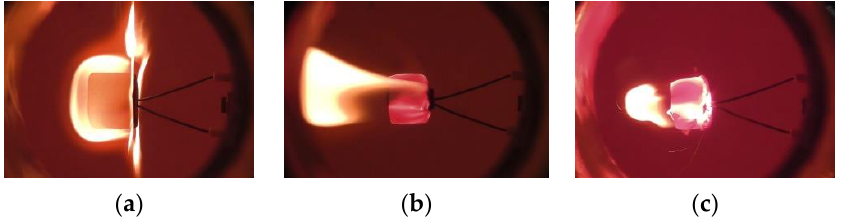
Figure 4. Stages of particle combustion at a furnace temperature of 800 °C and air flow velocity of 20 m s −1 , type A holder. Temperatures indicated under the figures are readings of the thermocouple in the center of a particle. ( a ) 138 °C, ( b ) 340 °C, ( c ) 820 °C. Volatiles are released and burned at the first stage. A flame envelope is torn off from the particle surface when the temperature in its center is as high as 330–350 °C (Figure 4b). The flame base is located at the back face of a particle. After termination of the in-